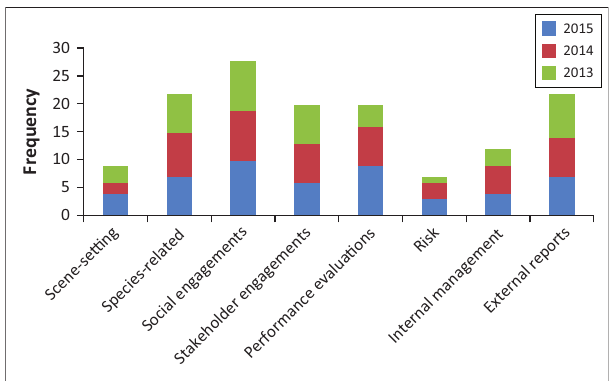
FIGURE 1: Biodiversity disclosures (2013–2015).